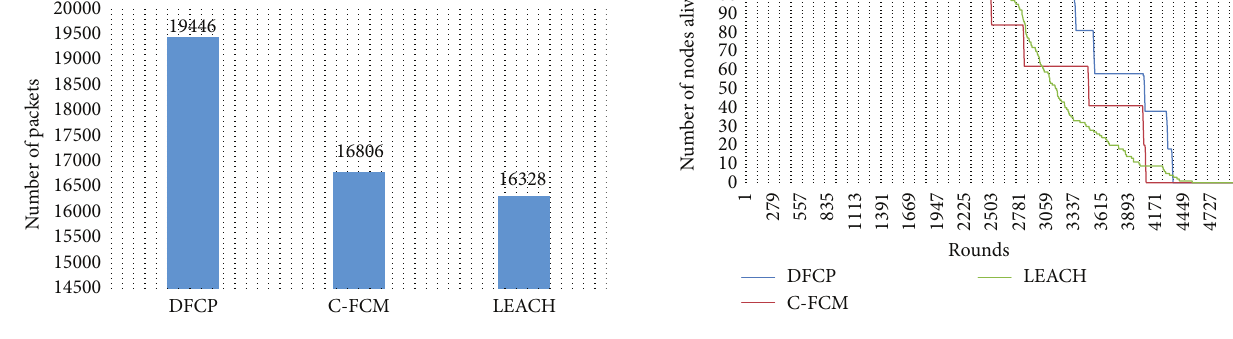
Figure 3: Total data delivered to the BS in 100m × 100 m WSN.